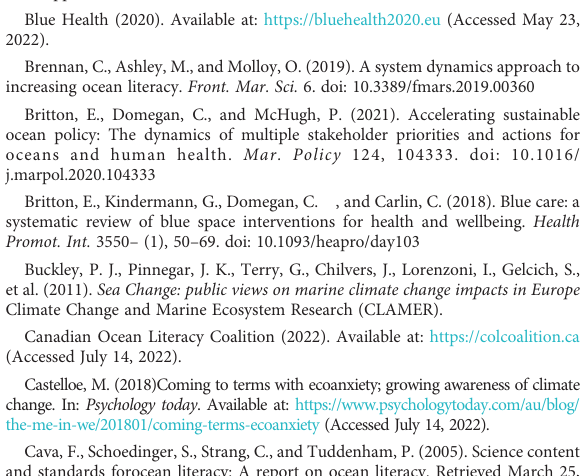
Figgener, C. (2015) Sea Turtle with straw up its nostril - “ NO ” to plastic straws . Available at: